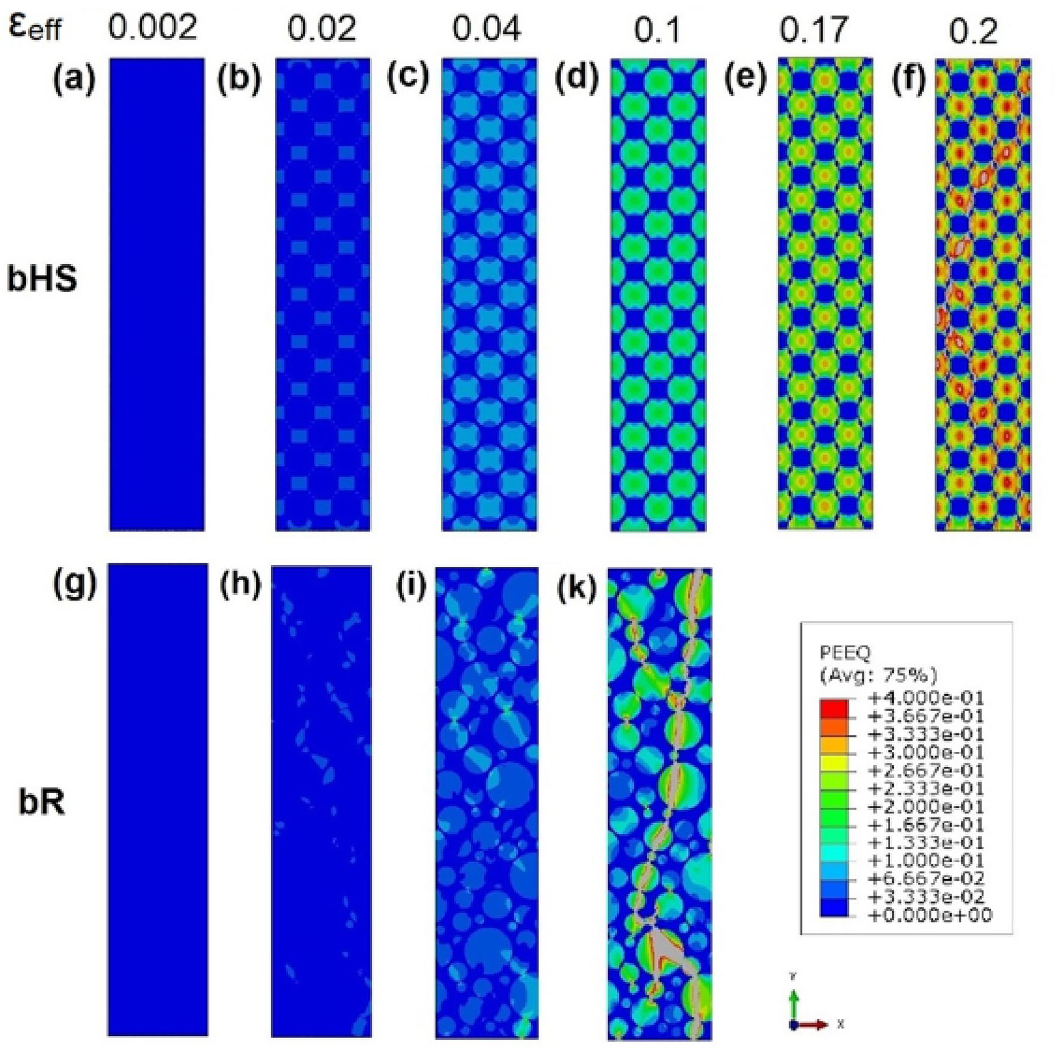
Figure 9. Distribution of plastic strains in selected areas around global strain localisation in bHS ( a – f ) and bR ( g – k ) specimens at various global plastic strain increments ε eff indicated at the top